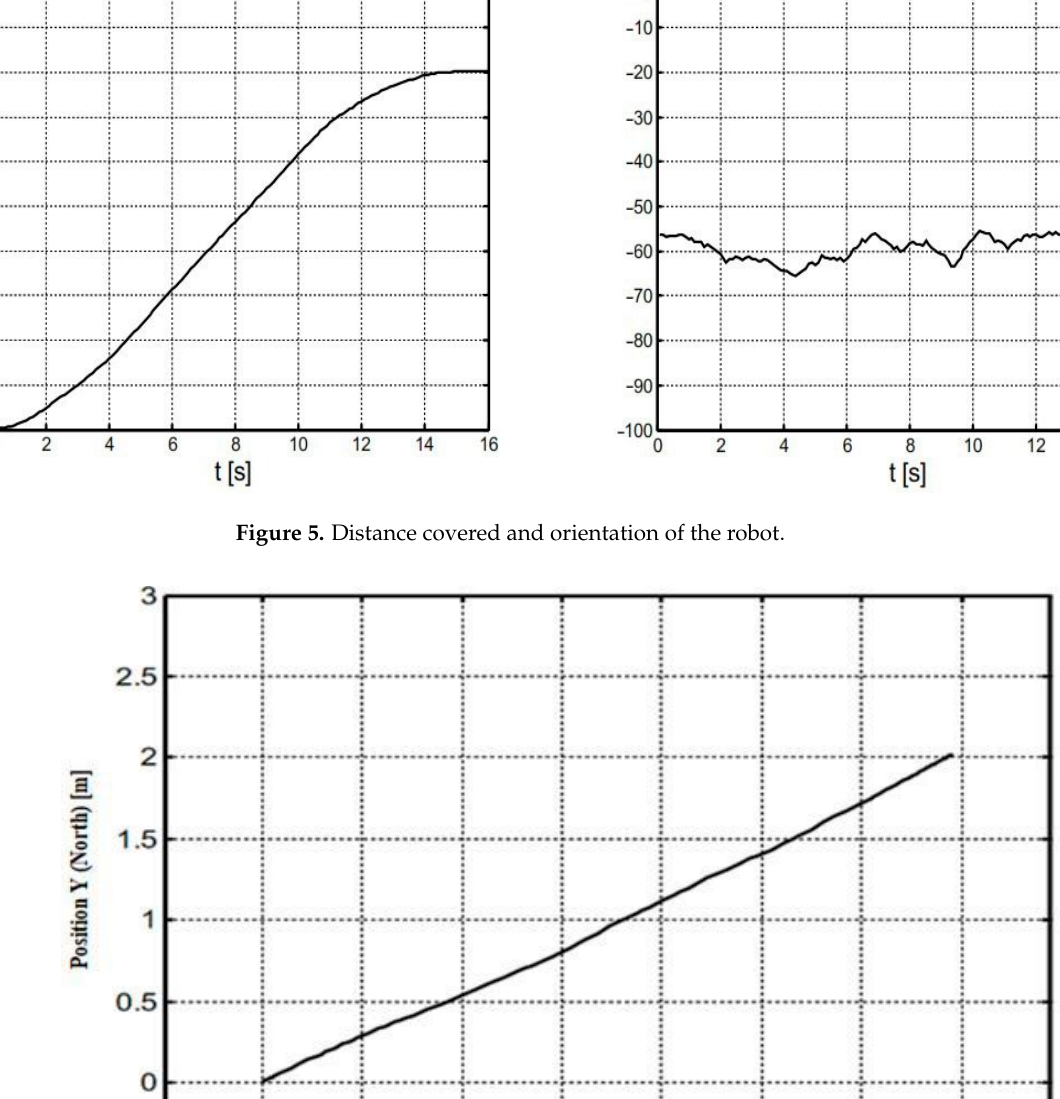
Figure 6. Position of the robot in the X-Y